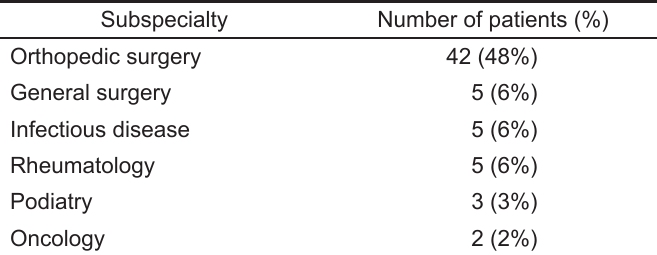
Table 3. Prevalence of consultations obtained in the ED observation unit for patients undergoing musculoskeletal